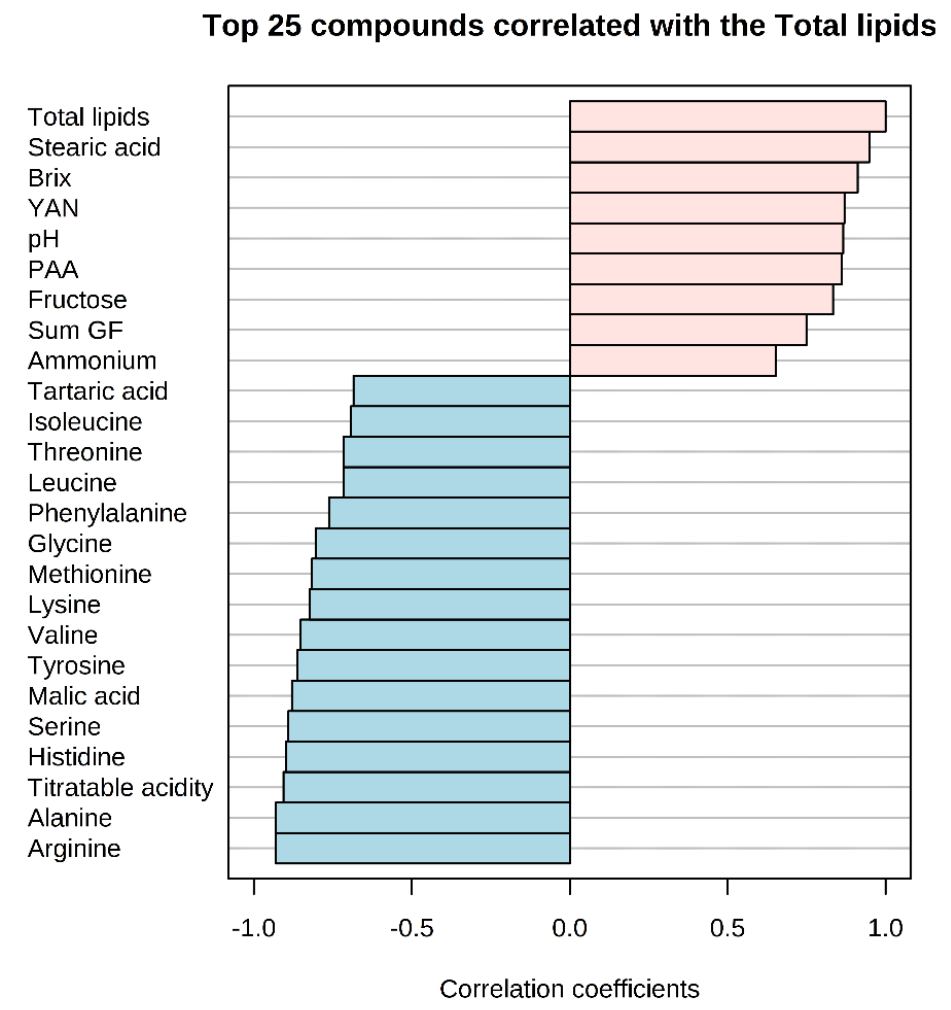
Figure 5. A pattern hunter plot showing the correlation of total lipids with different oenological parameters and nitrogenous compounds analyzed in the Sauvignon blanc and Pinot noir grape juices. Pink bars represent the positive correlation (Pearson r > +0.50) while blue bars show the negative correlation (Pearson r > − 0.50). YAN = yeast available nitrogen, PAA = primary amino acids, GF = glucose + fructose.